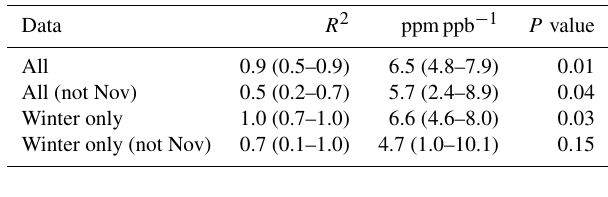
Table 2. CO ratios using the MHD 15th percentile as background value under different times using NAEI 2012 emissions inventory and measurements at TAC. Uncertainties shown are the 5th and 95th percentiles.